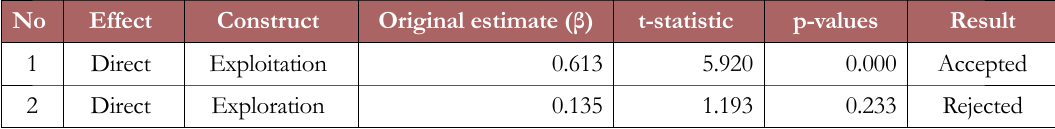
Table 9. Hypothesis test result for exploration and exploitation to OA in manufacturing industry